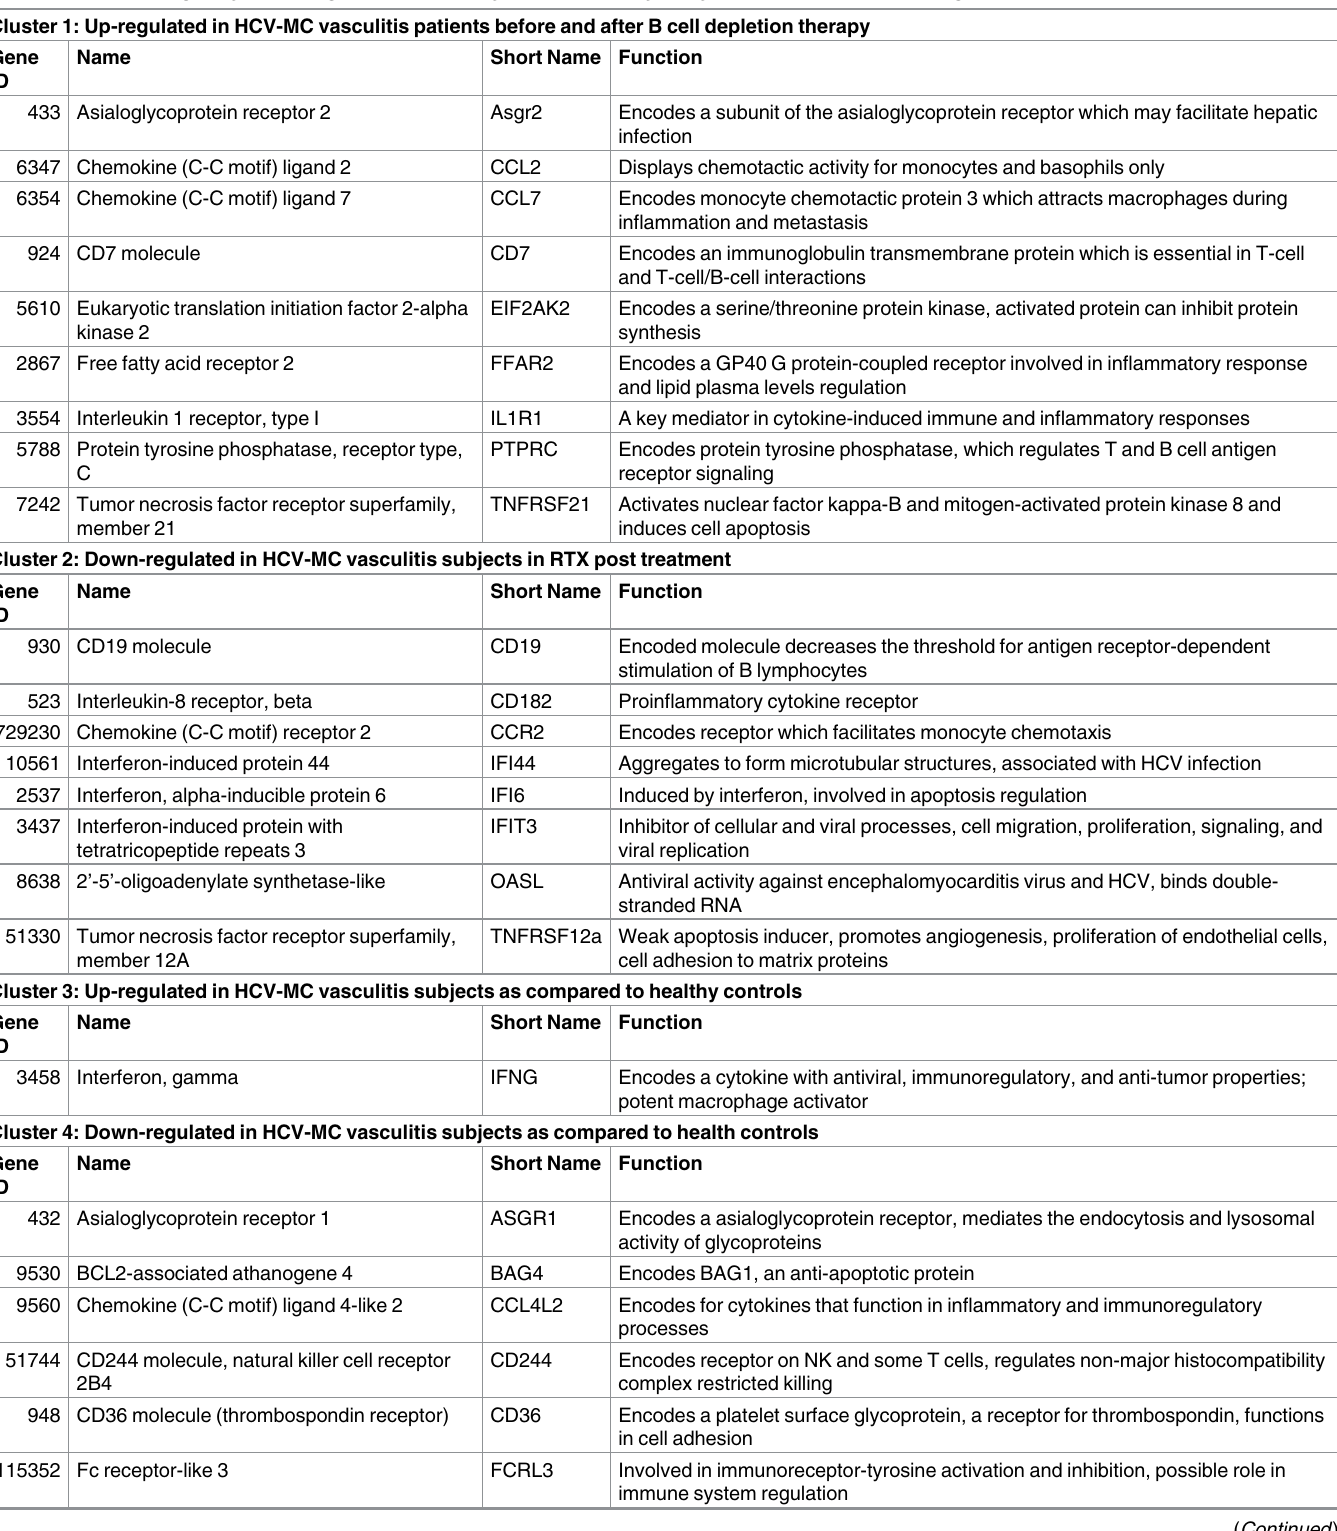
Table 2. List of biologically relevant genes identified by DNA microarrayanalysis and literature-driven